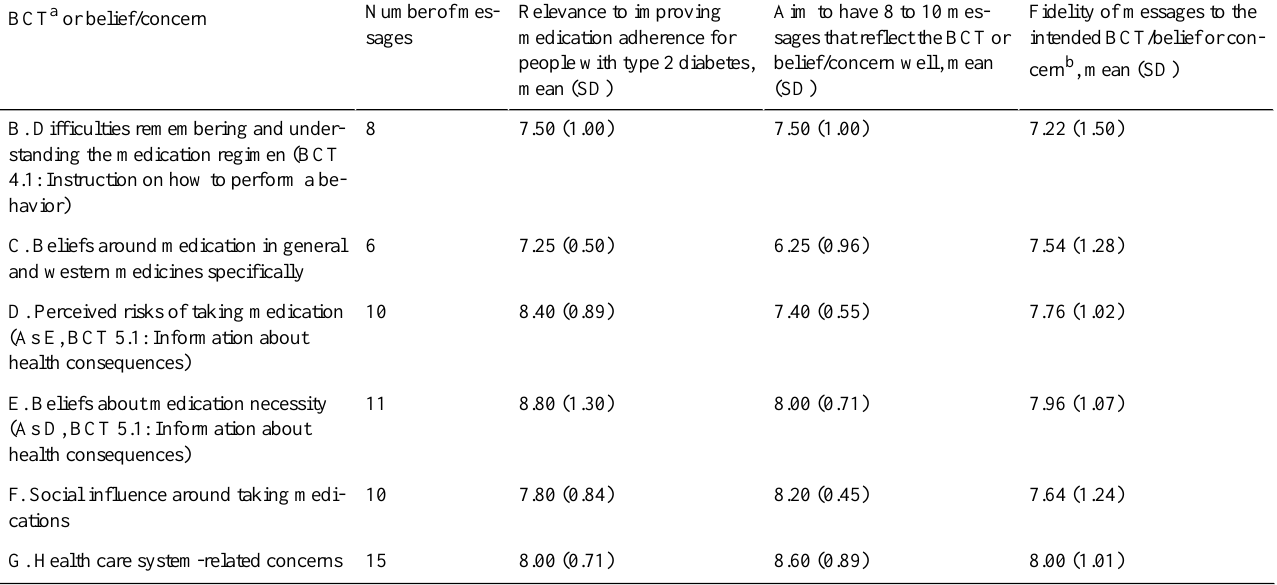
Table 2. Reasons for exclusion of behavior change techniques following study 1. Reason for exclusionBehavior change technique Missing taking medication was not thought to be habit; therefore it was thought there was no habit to habits8.4. Habit reversal reverse in the sense psychologists think of Conserving mental was concern that suggesting people with type 2 diabetes focus on medication adherence alone could